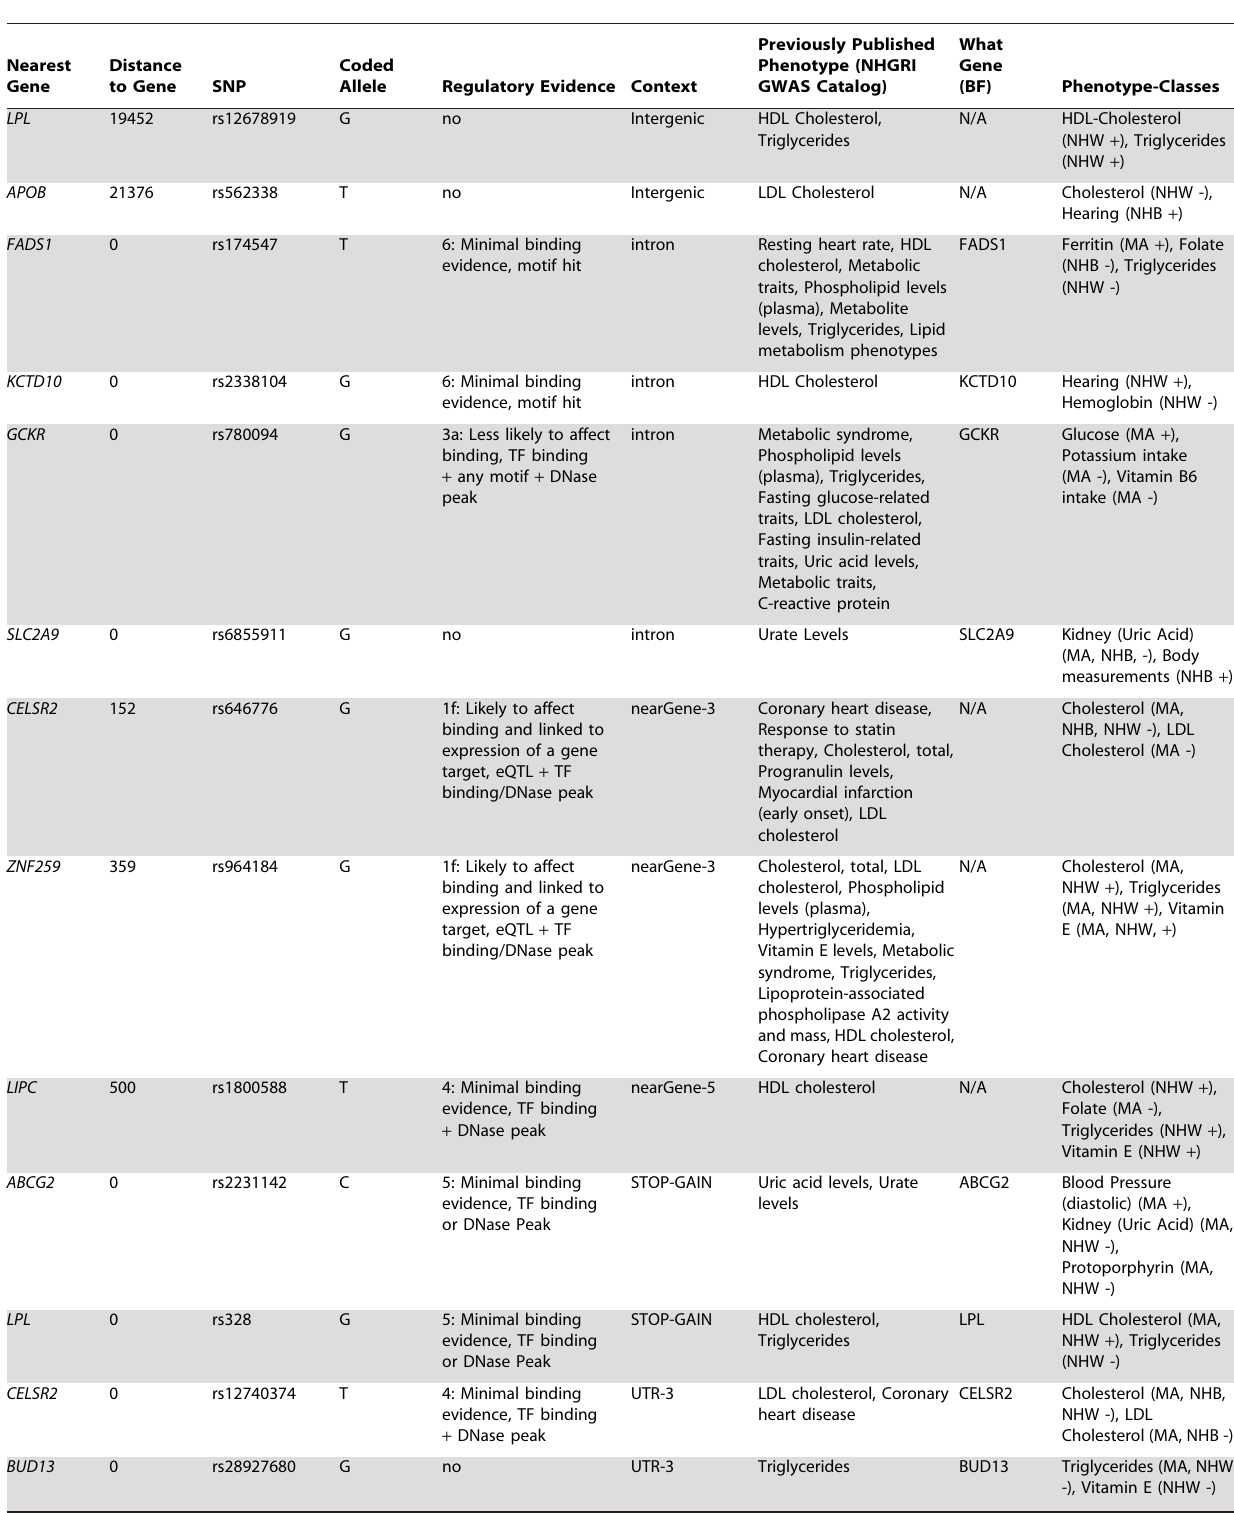
Table 4. Pleiotropic